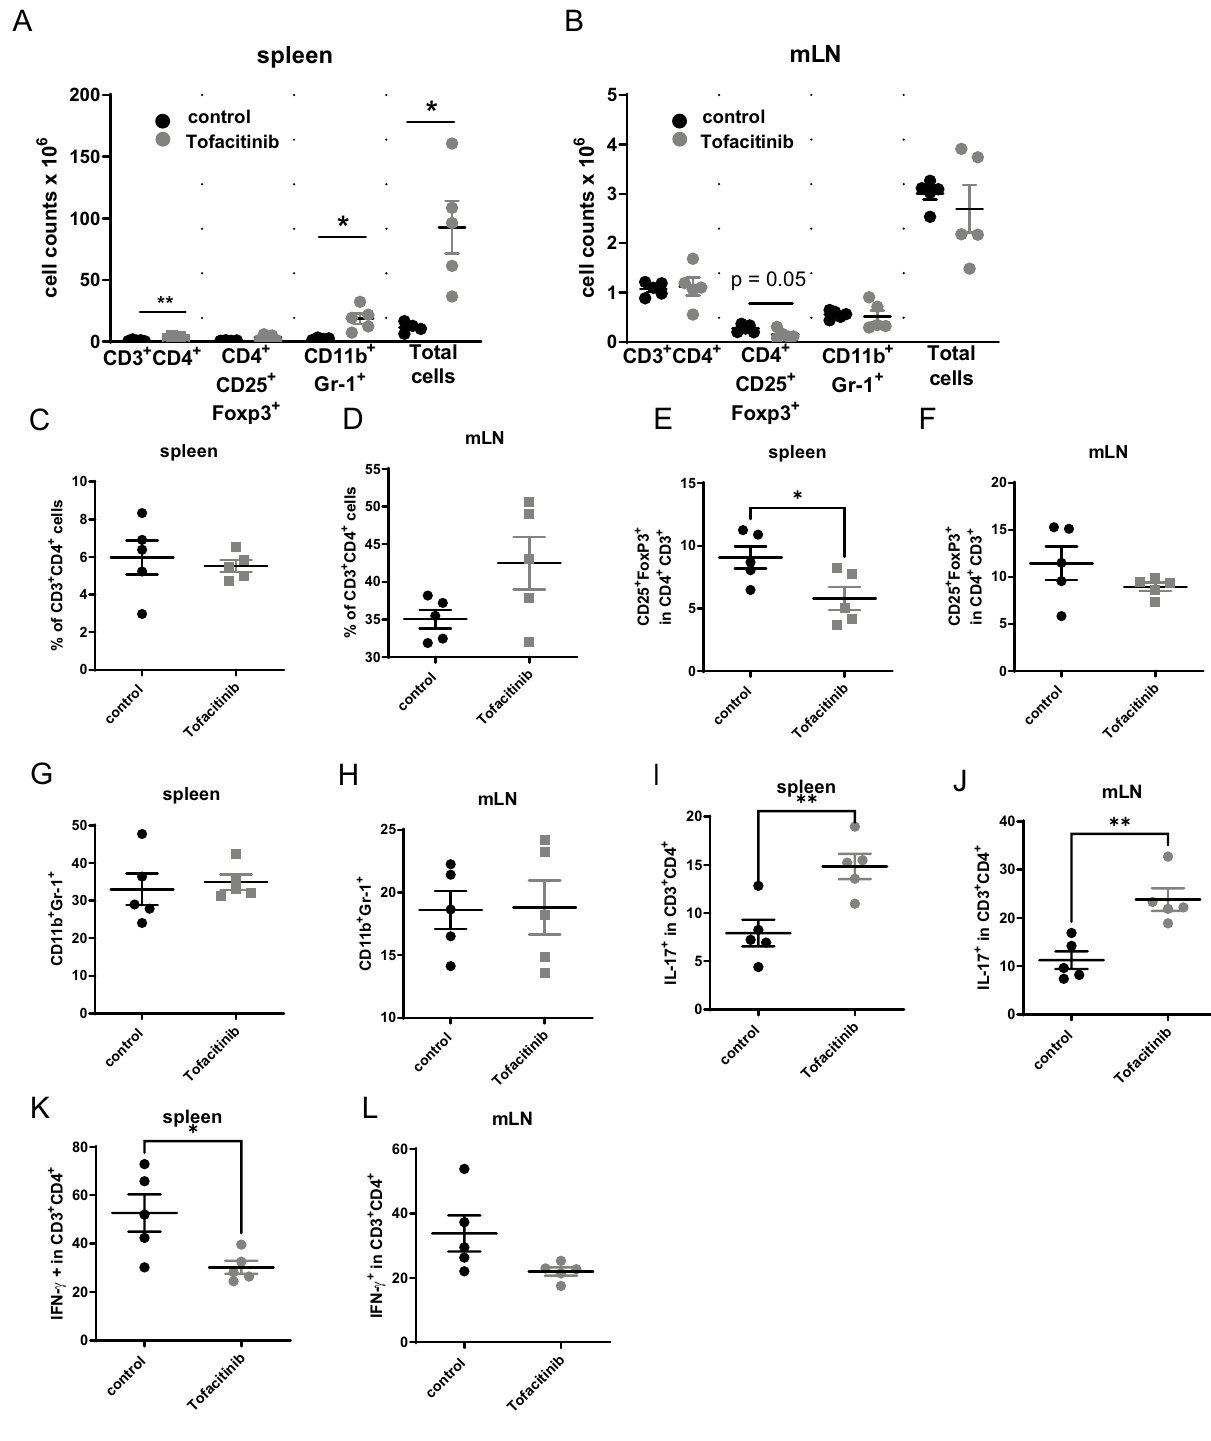
Figure 2. Low-doses of tofacitinib does not influence immune cell activation. ( A ) Absolute numbers of immune cells within the spleens assessed by flow cytometry (N = 4 controls, N = 5 Tofacitinib treated mice, two-tailed unpaired t-test were used). ( B ) Absolute numbers of immune cells within the mLNs assessed by flow cytometry (N = 5 controls, N = 5 Tofacitinib treated mice, p = 0.0084). Flow cytometric analysis was performed to determine percentages of ( C ) CD3+ CD4+ T cells within the spleen (** = 0.0084, * = 0.0121, * = 0.0120). ( D ) CD3+ CD4+ T cells within mLN. ( E ) % of CD25+ Foxp3+ in CD4+ CD3+ cells in the spleen (* = 0.034). ( F ) CD4+ CD3+ CD25+ Foxp3+ cells in the mLNs. ( G ) CD11b + Gr-1 + cells in the spleen. ( H ) CD11b + Gr-1 + cells within mLN. ( I ) IL17+ T cells within the spleen (** = 0.0066). ( J ) IL-17+ T cells within mLN (** = 0.0030). ( K ) IFN-γ+ T cells within the spleen (* = 0.0253). ( L ) IFN-γ+ T cells in mLN. In all data sets each dot represents one animal, error bars SEM, two-tailed unpaired t-tests were used to test for